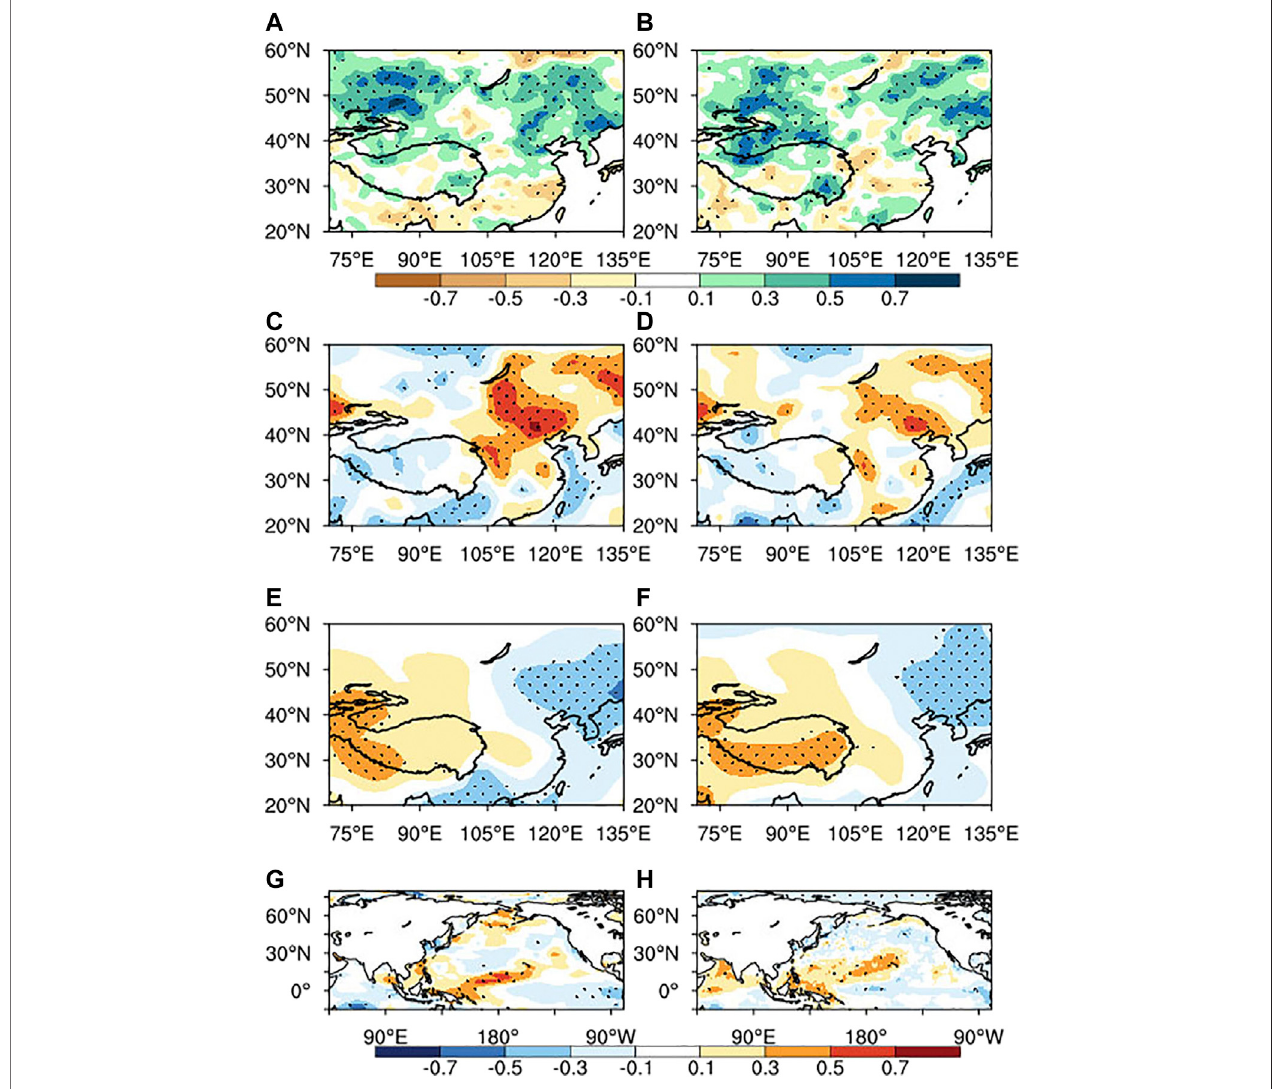
FIGURE 5 | (A,C,E) Correlation coef fi cients between the PC1 of winter NH snow cover and spring (A) soil moisture, (C) latent heat fl ux and (E) land surface temperature. (B,D,F) As in (A,C,E) but for the PC1 of summer CHDEs. Black dots indicate values signi fi cant at the 95% con fi dence level.